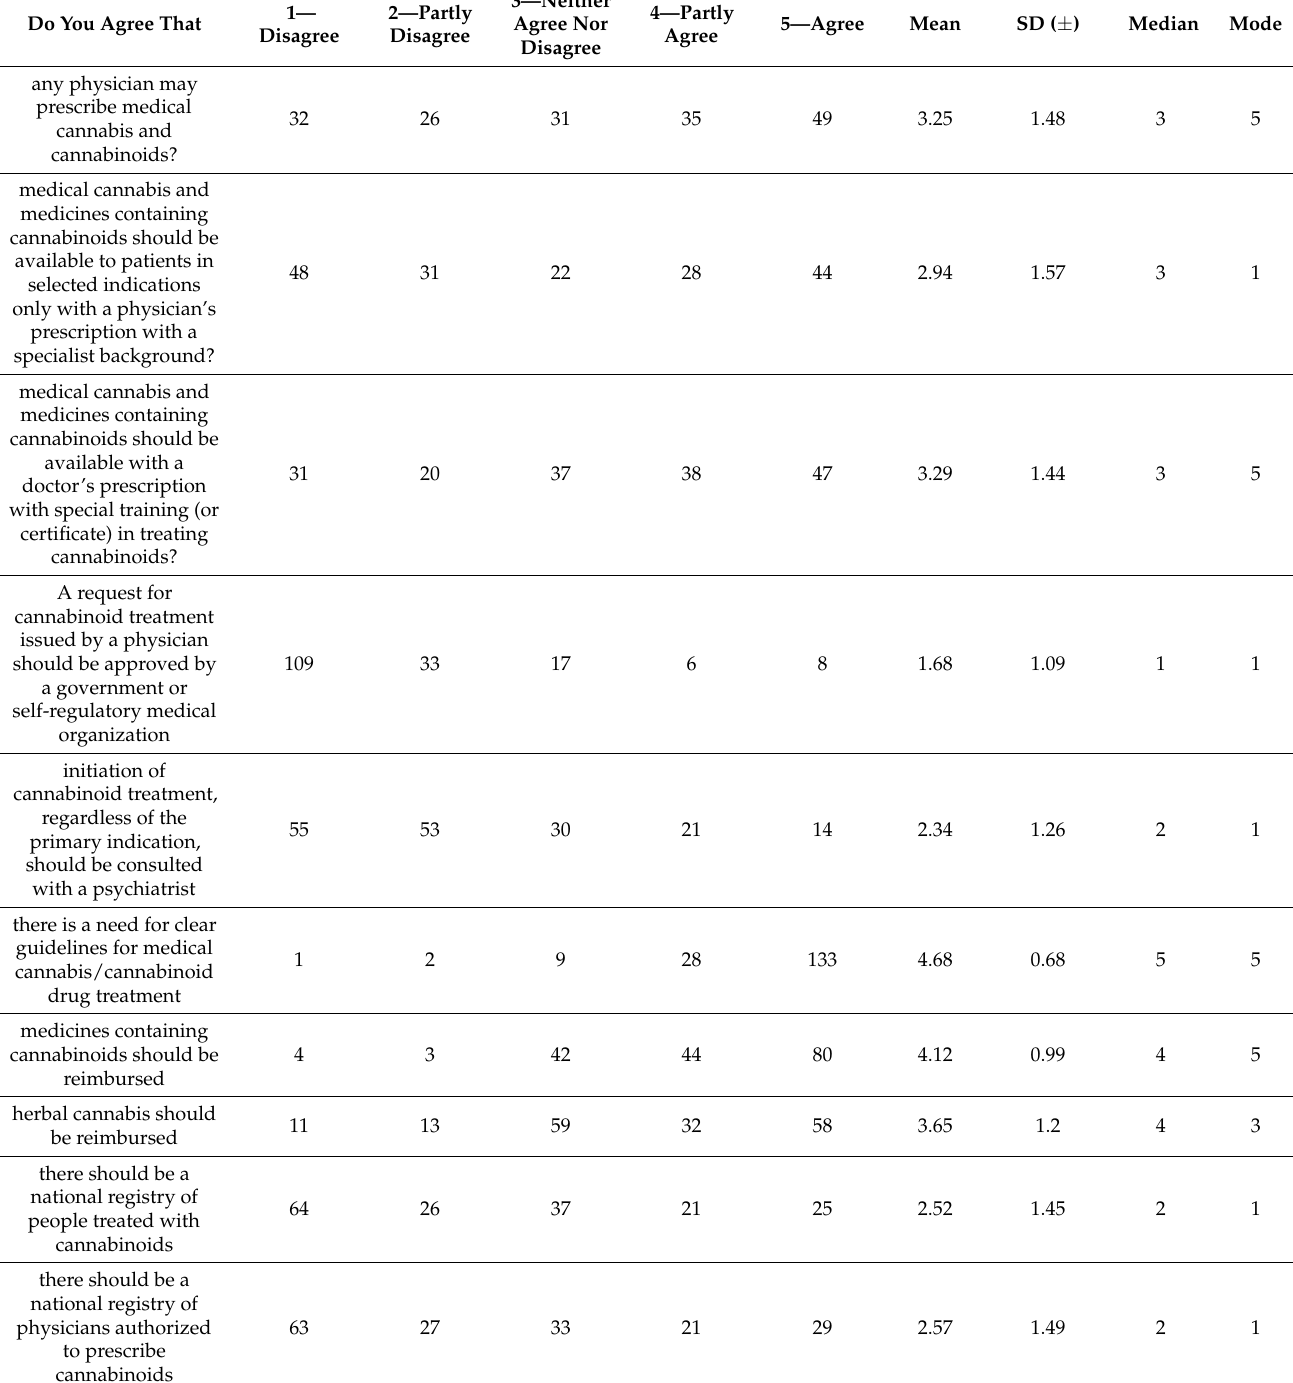
Table 4. Access to cannabinoid, systemic, medicine-related